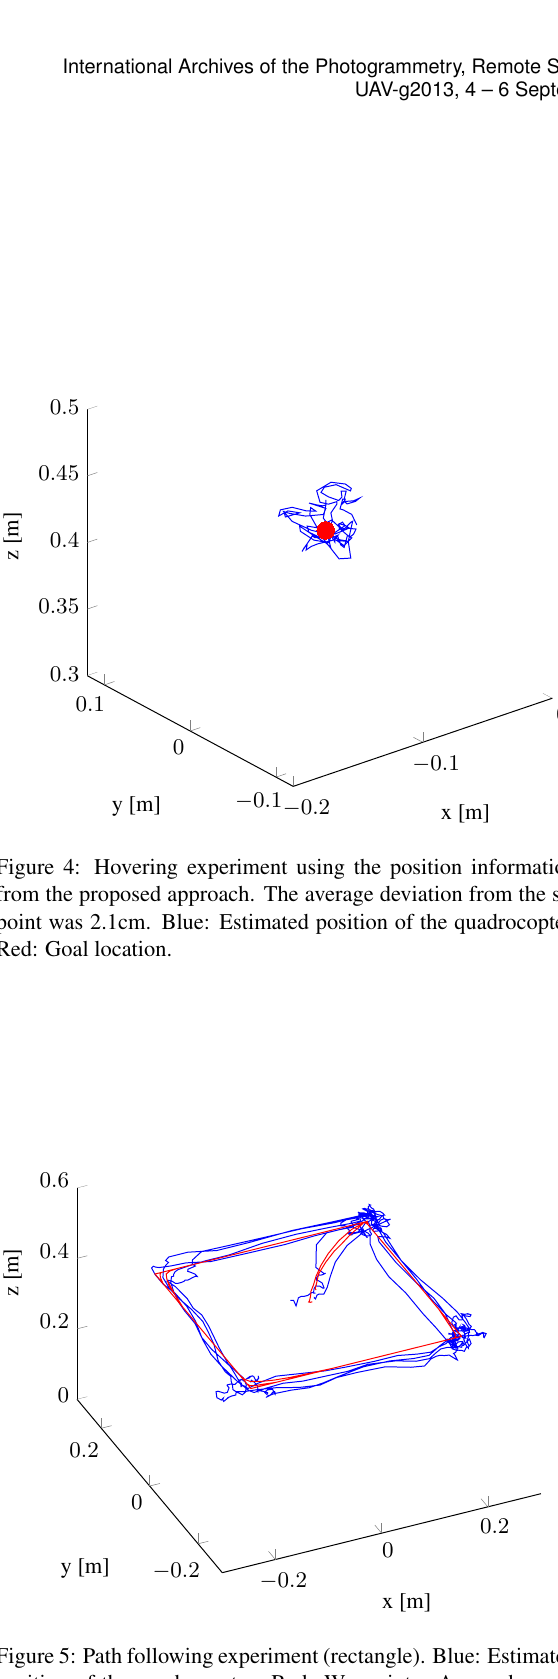
Figure 7: Couch corner in our lab. In this experiment, a human pilot specified the waypoints during scanning. The quadrocopter approached these waypoints using our approach. Top: Image from external camera. Bottom: Reconstructed 3D models from side view and top